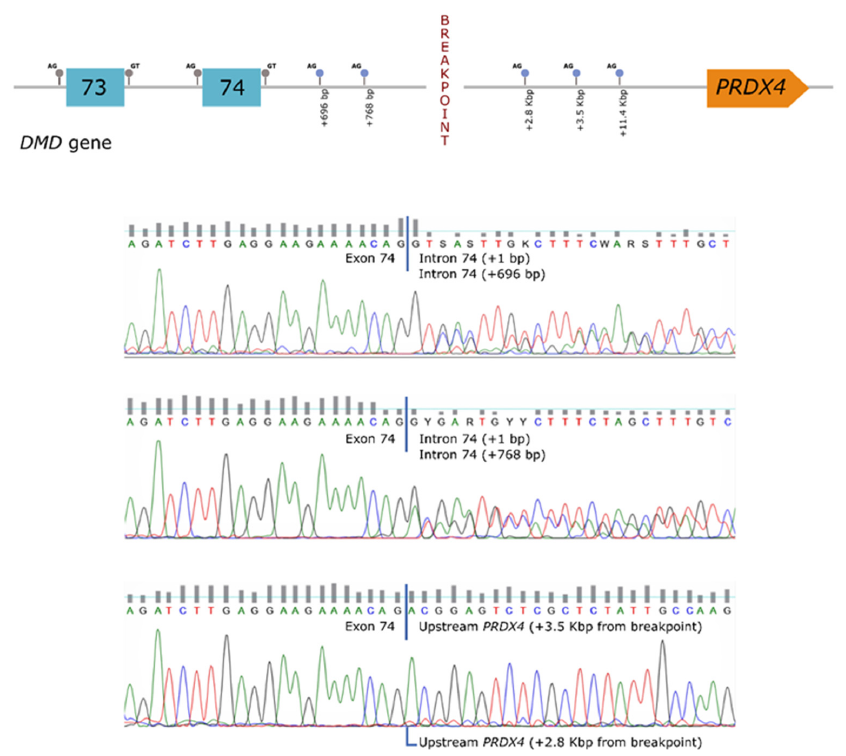
Figure 2. Transcript analysis. Several transcripts were detected in the patient, representing the use of cryptic splice-sites located both in the DMD gene (intron 74), as well as in the region upstream PRDX4